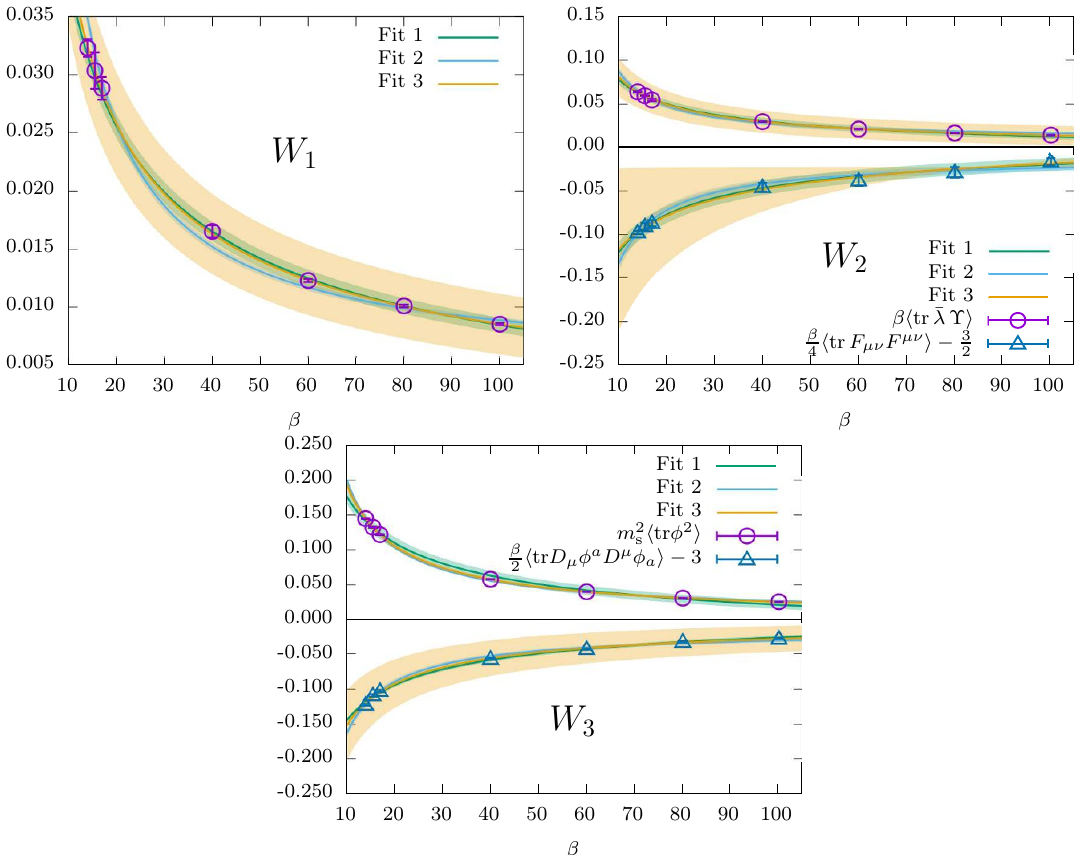
Figure 7. Ward identity W 1 and various terms contributing to the identities W 2 and W 3 in (4.4) for di(cid:11)erent values of (cid:12) together with three di(cid:11)erent (cid:12)ts used for the continuum extrapolation. The theoretical value in the supersymmetric continuum limit for W 1 is